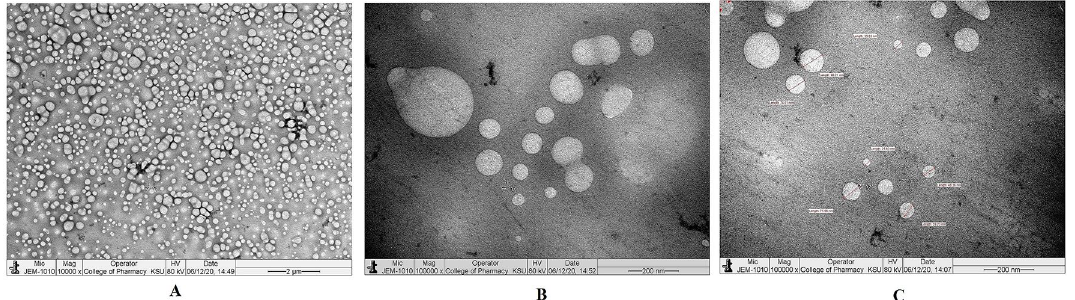
Figure 5. Transmission electron microscope study. ( A ) Morphology of injectable CCNP colloidal solution under ×10,000 magnification. ( B ) Morphology of injectable CCNP colloidal solution under ×100,000